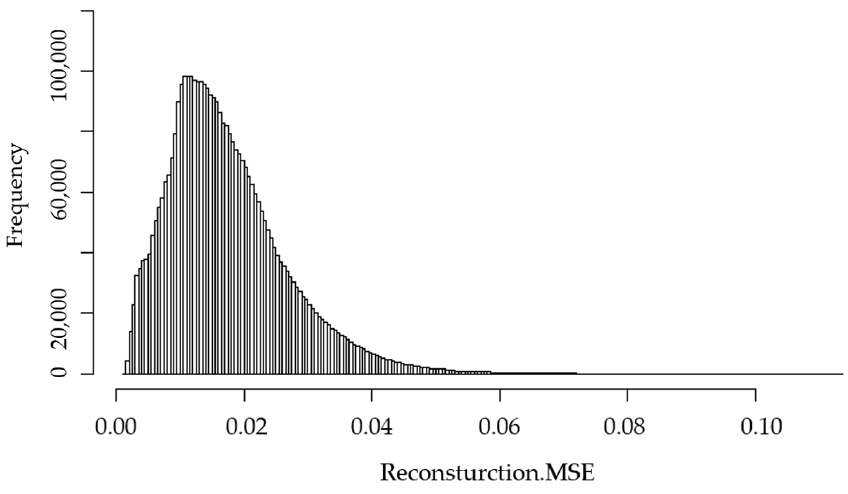
Figure 1. Histogram of Reconstruction. MSE for birth records after using autoencoders. After applying the noise removal steps, 5.07% of the initial 3,803,484 observations are removed. The proportion of singleton preterm birth at 7.73% in the final dataset remains close to the initial distribution at 8.02%. The final dataset includes 3,610,827 observations with 77 variables. Figure 2 shows all of the data preparation steps. Note that “n1” is the number of observations, and “m1” is the number of variables in the CDC dataset; “n2” and “n3” shows the number of counties in CHR and AHRF, respec- tively. “m2” and “m3” shows the number of variables in CHR and AHRF, respectively. Data visualization is a challenging but insightful task in this study due to a large number of observations. We used Violin graphs from the ggplot2 package in R to plot the data and gain more information about the features and their relationship with preterm birth. The violin graph shows the density of data points at each level. Figure 3 shows two samples of these graphs. Figure 3a shows the kernel distribution of “History of Preterm” vs. “Gestational Age”. This graph shows that mothers with a history of preterm delivery (represented as 1 in the graph) have a lower average gestational age (represented with a red dot) compared to those without such a history. In addition, the dotted vertical line separates the preterm and full-term births. Preterm births are at the left side of the vertical line, and full-term births are on the right. Figure 3b shows the kernel distribution of “Age of Mother” vs. “Gestational